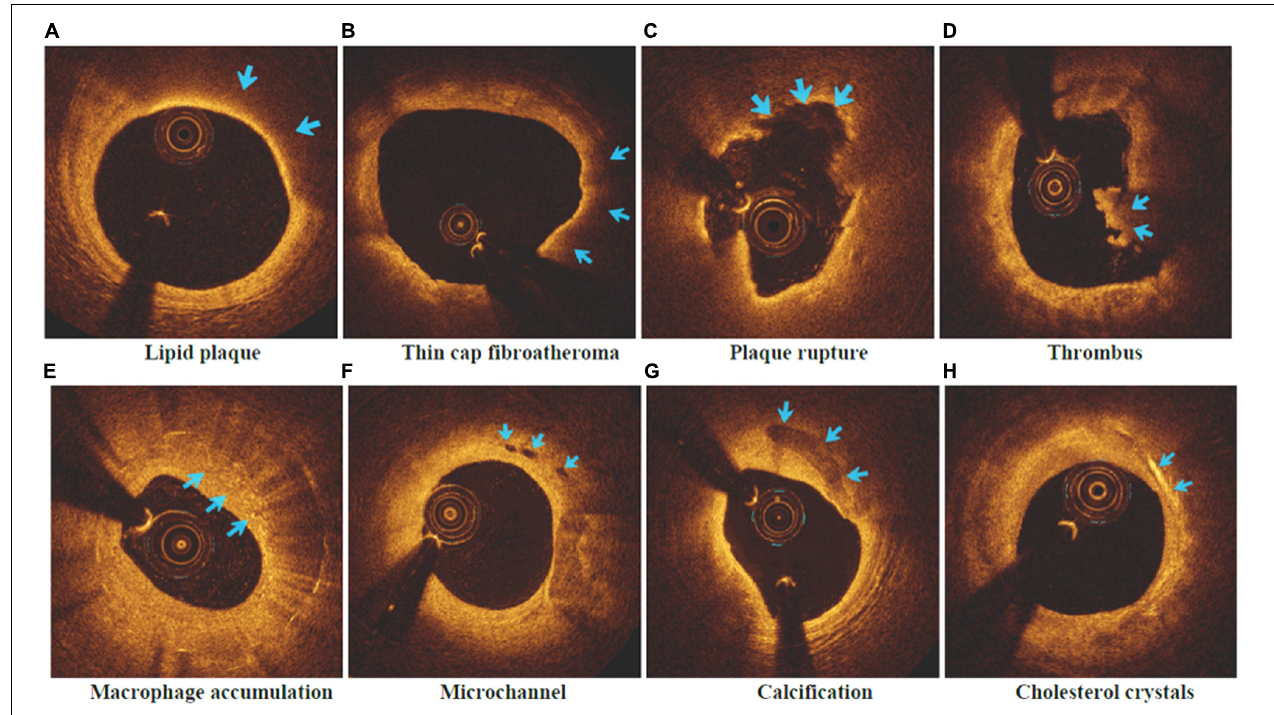
FIGURE 2 | Vulnerable plaque and related characteristics in OCT images. (A) Lipid plaque; (B) Thin cap fibroatheroma; (C) Plaque rupture; (D) Thrombus; (E) Macrophage accumulation; (F) Microchannel; (G) Calcification; (H) Cholesterol crystals.